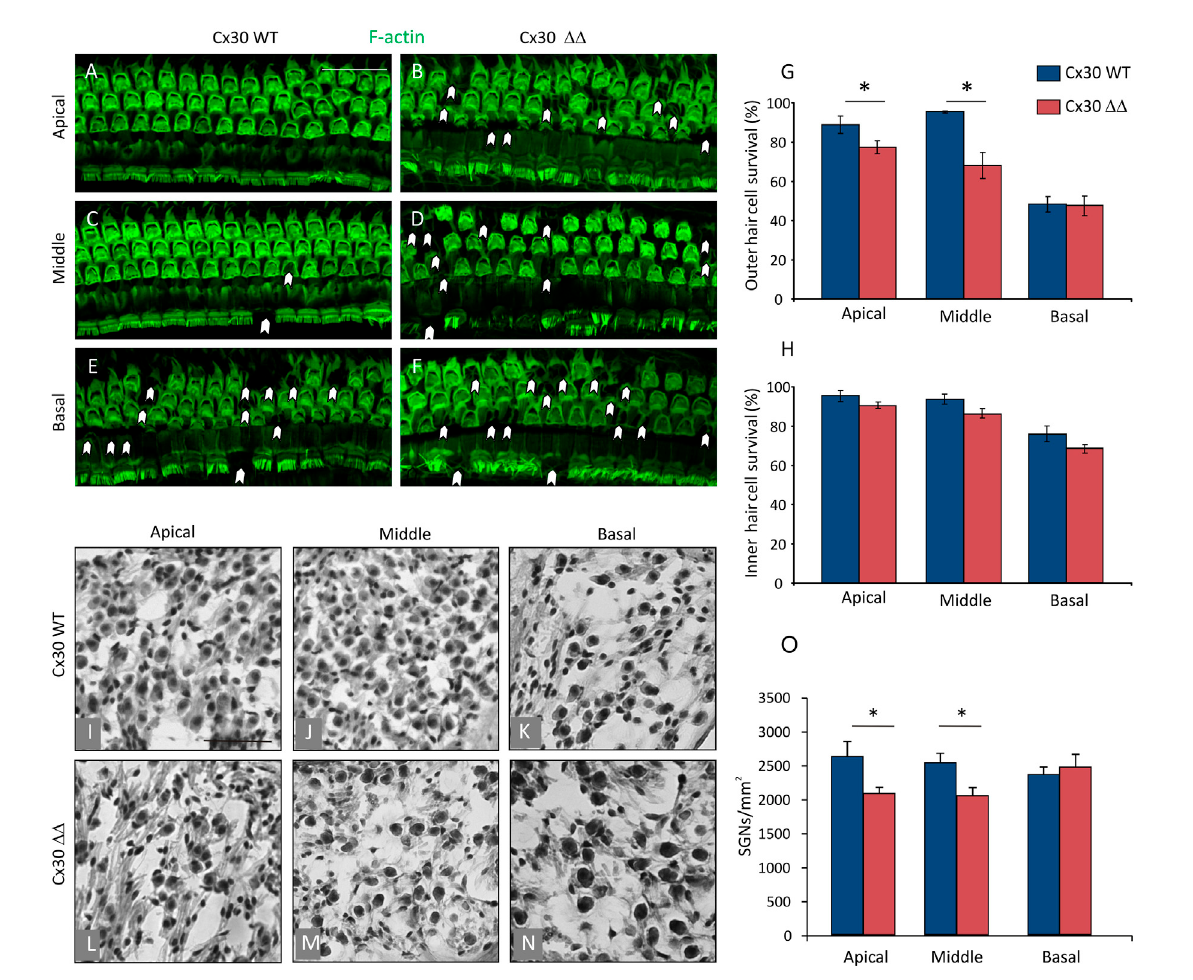
FIGURE 2 Connexin 30 de fi ciency exacerbates morphological cochlear damage induced by aging. (A – F) : Surface preparations of the basilar membrane with the organ of Corti from 12 MoA Cx30 WT and Cx30 ΔΔ mice; images from apical, medial, and basal turns were obtained by maximal intensity back projection of 15 confocal optical sections from a 0.8 µm step through-focus sequence (z-stack). Actin fi laments were stained with ActinGreen 488ReadyProbes(green).Arrowheadsindicatemissingcells.Scalebar:50 μ m. (GandH) :Histograms(mean±S.E.M.)representthepercentage of OHC and IHC survival in the three cochlear turns from Cx30 WT and Cx30 ΔΔ animals. (I – N) : Representative SGN hematoxylin-eosin staining in Cx30WT (I – K) andCx30 ΔΔ samples (I – N) inapical,middle,andbasalcochlearturns. (O) :Histograms(mean±S.E.M.)representthenumberofSGNs per mm 2 in the three different cochlear turns. N = 4 cochleae/group. Asterisks indicate signi fi cant differences between groups from Student ’ s t-test (* p <